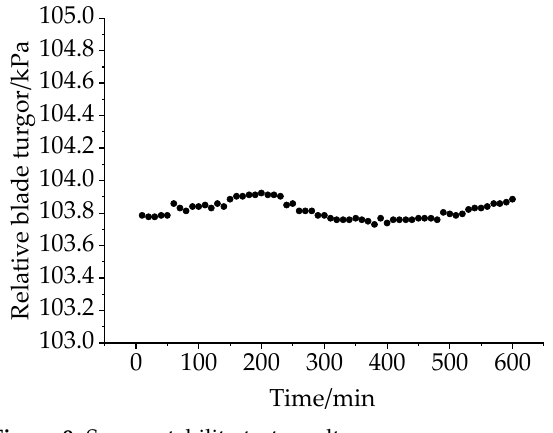
Figure 9. Sensor stability test results.